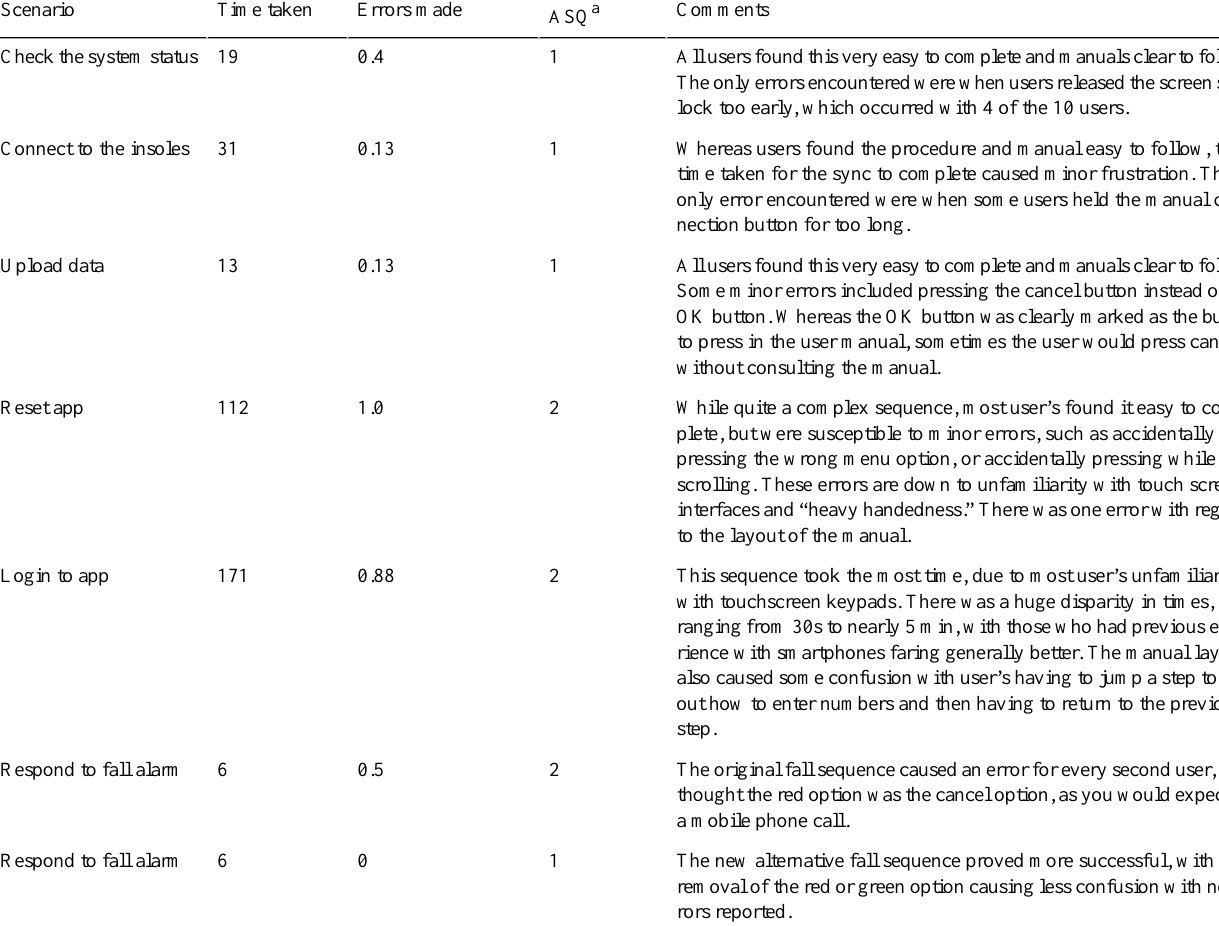
Table 13. Performance metrics for each scenario during user testing with working prototype 2, with related commentary as observed during the testing. The after scenario questionnaire (ASQ) score ranges from 1-7, where 1=best score possible and 7=worst score possible. CommentsASQ a Errors madeTime takenScenario